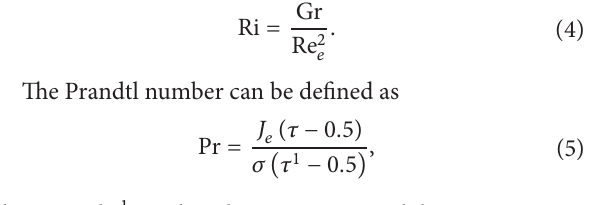
Figure 1: Schematic of the physical model and coordinate for the problem with boundary